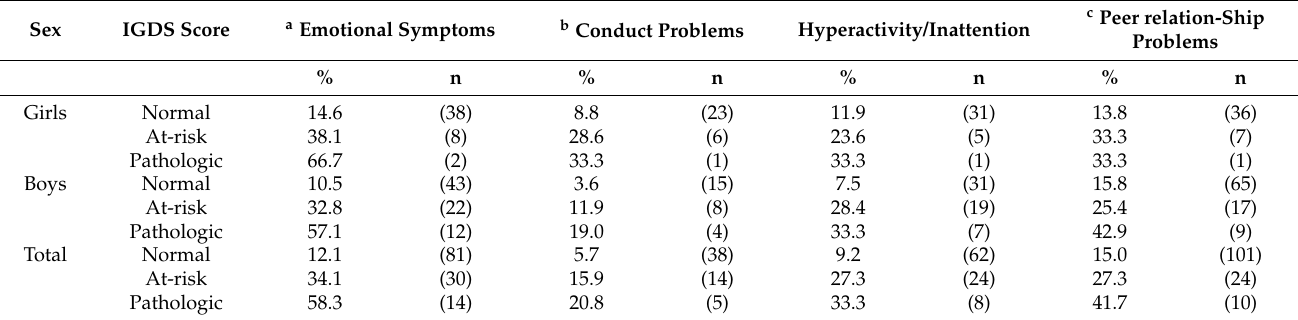
Table A5. Percentages of children and adolescents screened with “borderline/clinical” SDQ results according to gaming group classification in the 2018